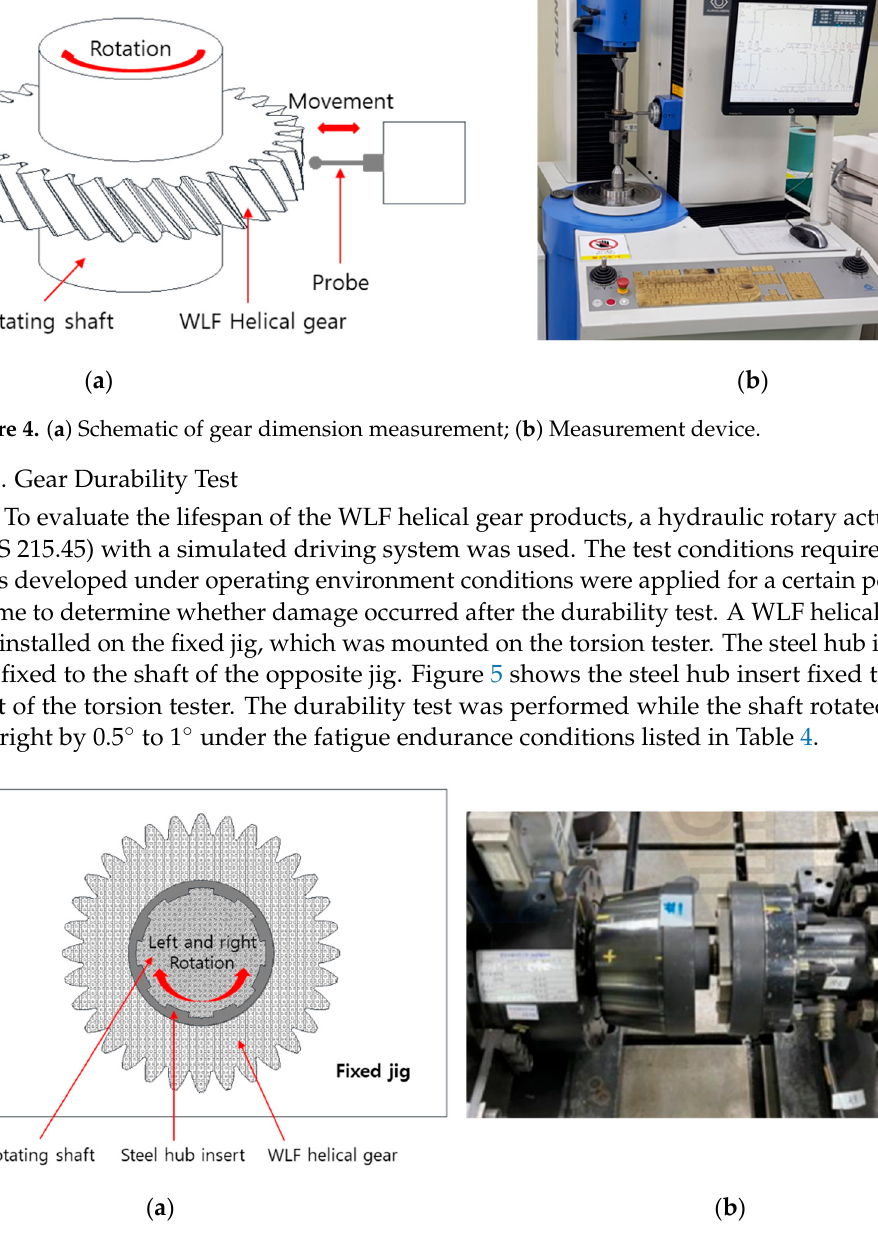
Figure 5. ( a ) Schematic of the gear durability test; ( b ) Gear durability